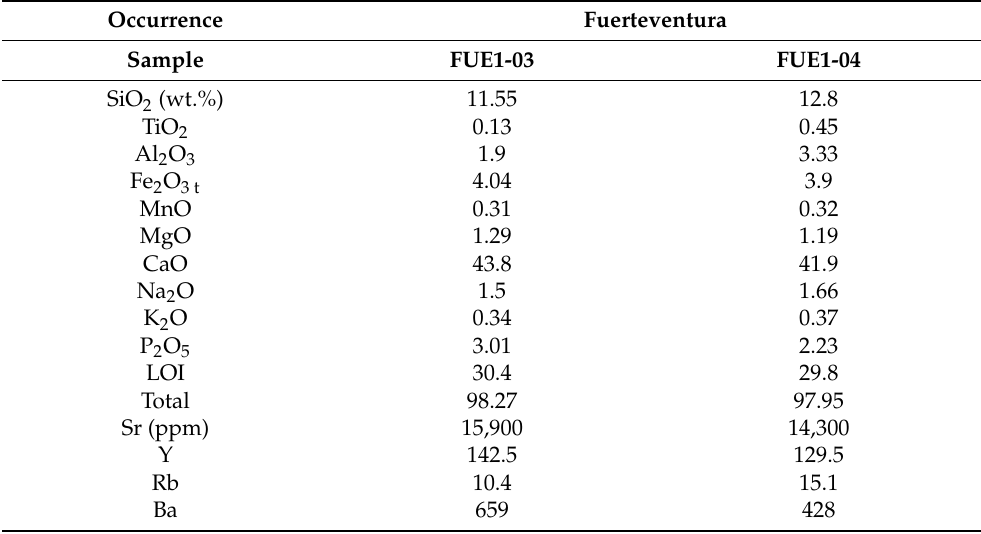
Table 1. Major and trace element compositions of Fuerteventura whole-rock carbonatites.